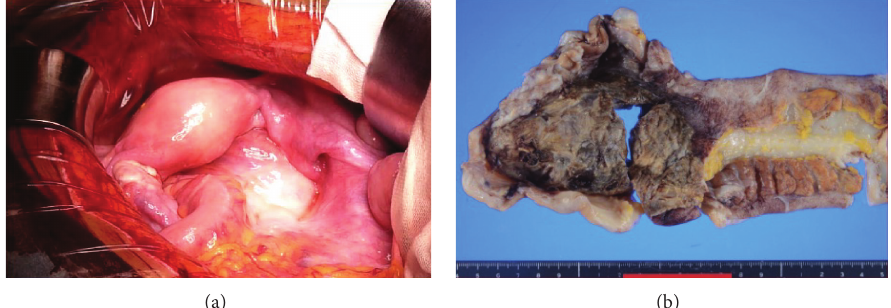
Figure 4: (a) Lower anterior resection with lateral pelvic lymphadenectomy was performed after chemoradiation with S-1 (TS-1, an oral fluoropyrimidine). The rectum was swollen. (b) Histopathology of the solid tumor beneath the area of ulceration prepared via formalin fixation. A localized advanced rectal cancer was diagnosed, pStage IIA (pT3 pN0